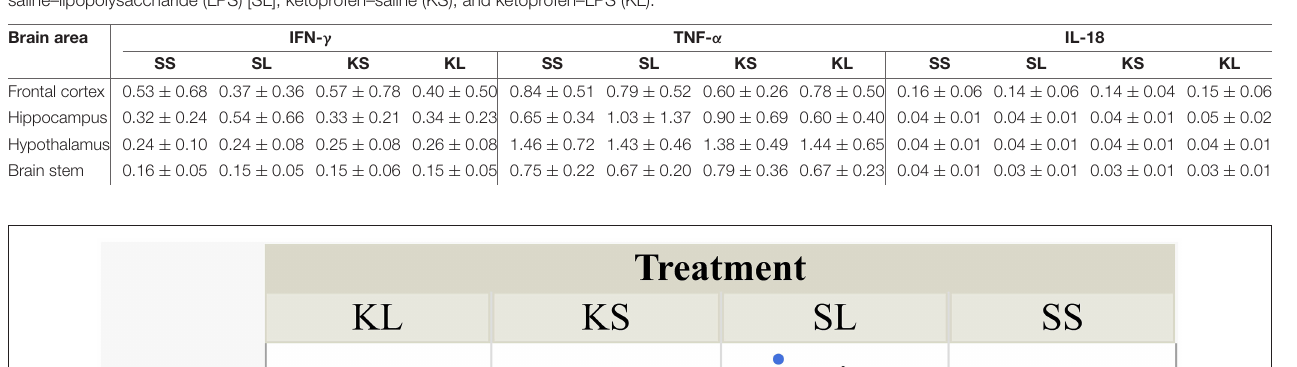
kynurenine–tryptophan ratio [KYN/TRP, F (treatment × time point) (3,27.28) = 2.17, p = 0.11] was lower at 72 h compared to baseline in SS pigs ( p =